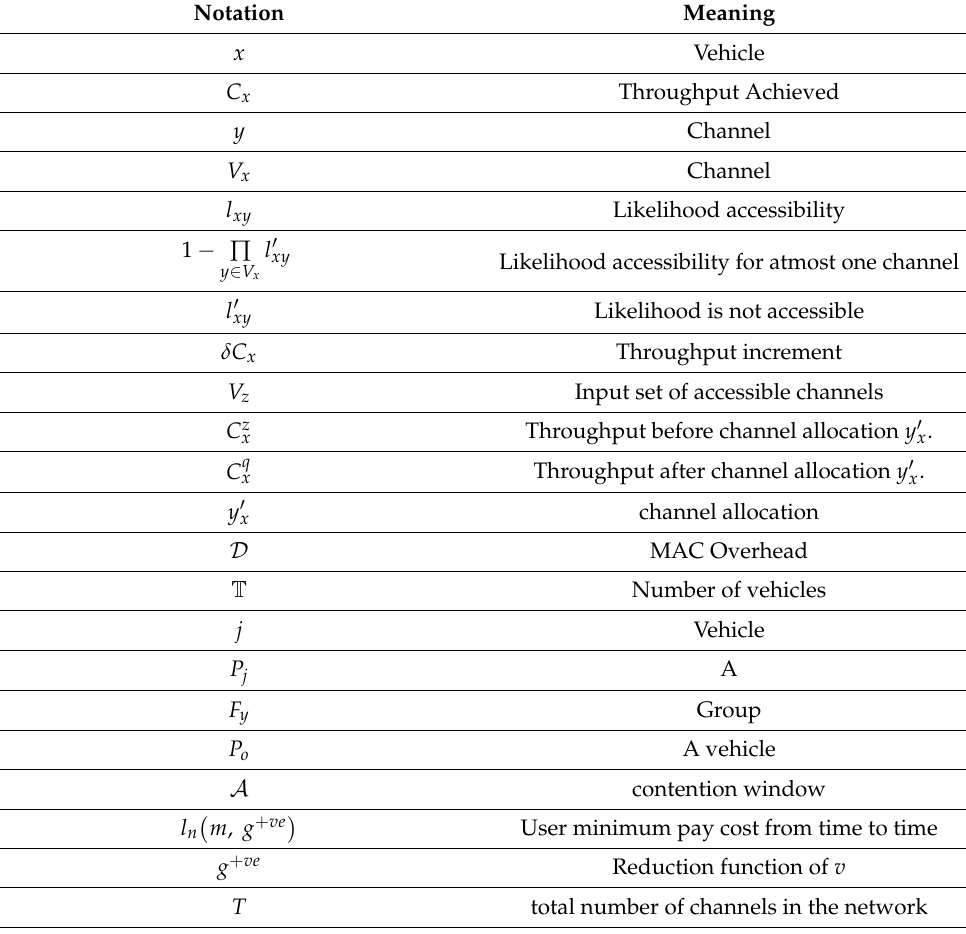
Table 1. Variable